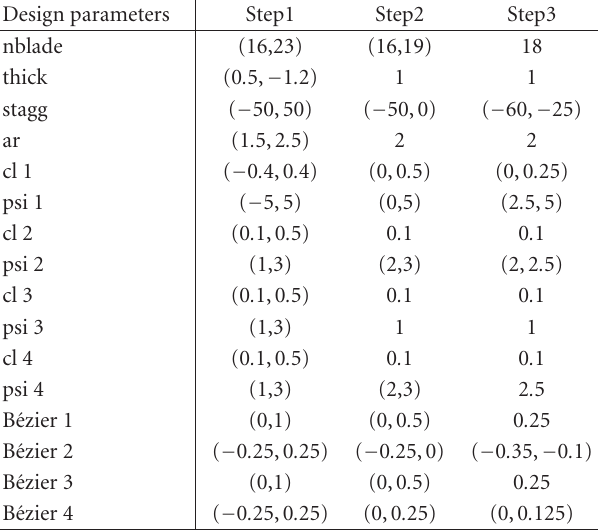
Table 5: Comparison between the variable ranges in the three phases of the optimization.